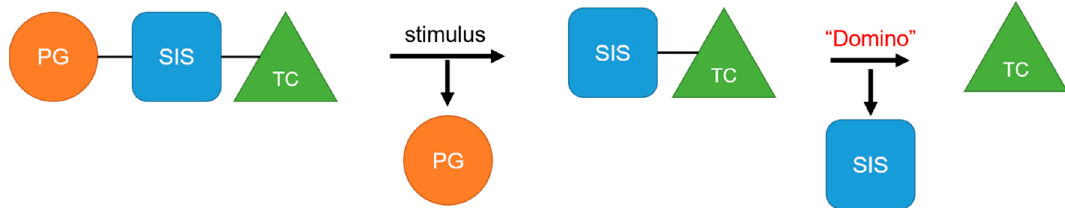
Figure 9. Schematic representation of a self-immolative spacer. PG, SIS and TC stand for protection group, self-immolation spacer and target compound, respectively.